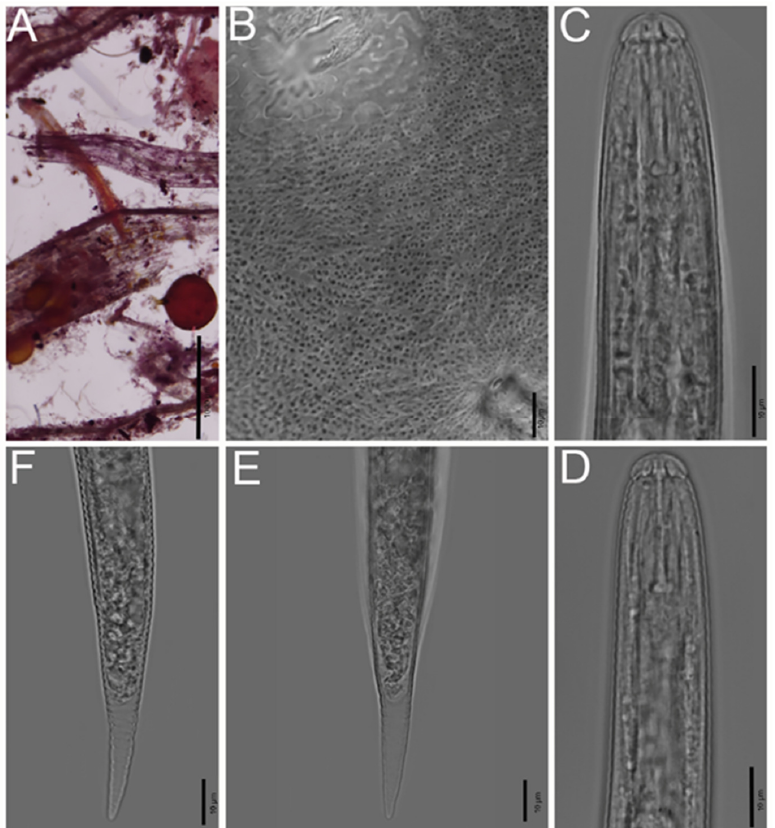
Figure 1. Golden nematode cysts extracted from the soil and root samples of potato cultivar Spunta (El Khatatba Area, Egypt). A: cysts; B: posterior end showing the vulva and anal openings; C, D: anterior end of J2’s; E, F: posterior end of